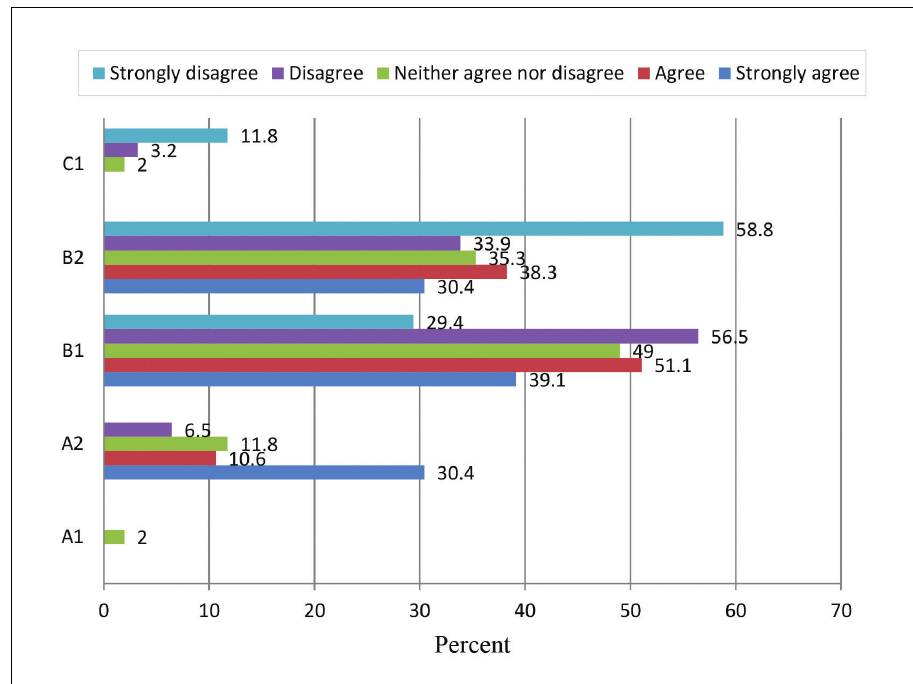
Figure 4. Participants’ level of anxiety in the foreign language class as com- pared to other classes with respect to their foreign lan- guage